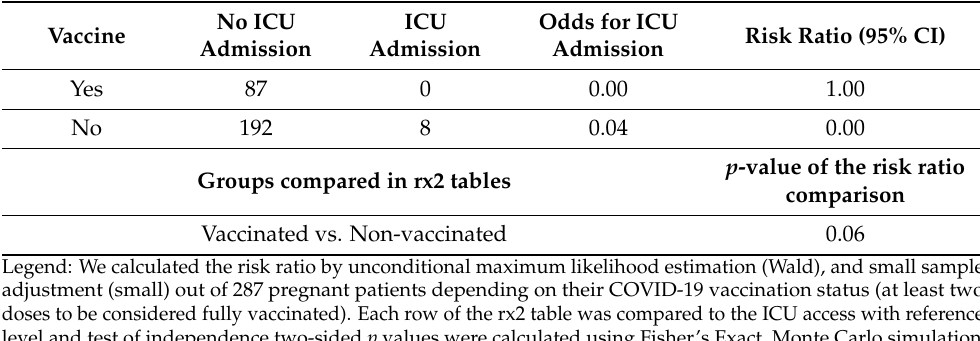
Table 5. Risk ratio estimation and confidence intervals for admission to the step-up unit (ICU) for severe-critical COVID-19 health issues based on vaccination status.